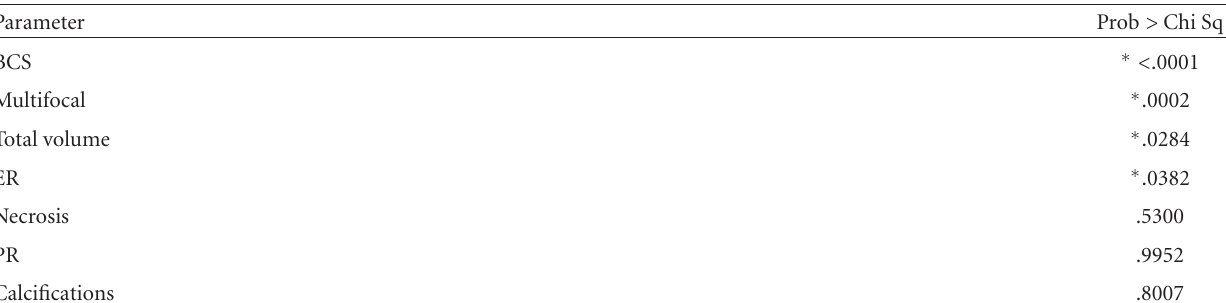
∗ Significant predictor of re-excision. The P values of the chi-squared test show the significance of each parameter as a predictor of the response variable, rate of re-excision surgery. If the P value is less than .05, then the parameter is considered significant and is a good predictor in the model for